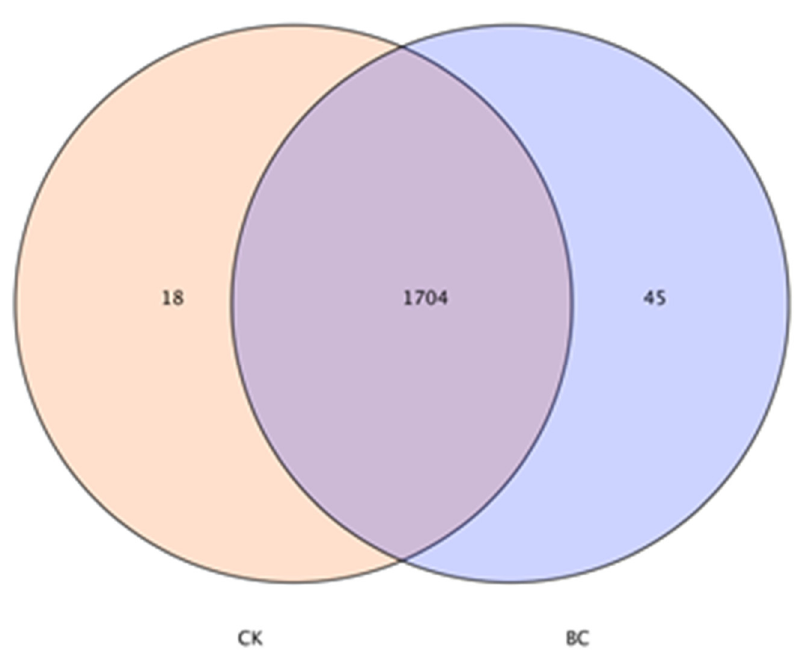
Figure 5. Ven diagram of soil bacteria. CK, conventional fertilizer; BC, biochar with conventional